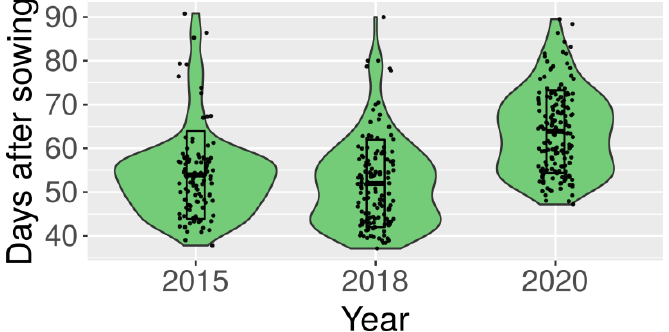
Figure 1. Distribution of the mean number of days from sowing to flowering in white lupin germplasm collection in years 2015, 2018 and 2020. Plants were cultivated in greenhouse without pre-sowing vernalization. Rectangles visualize mean and standard deviation values.